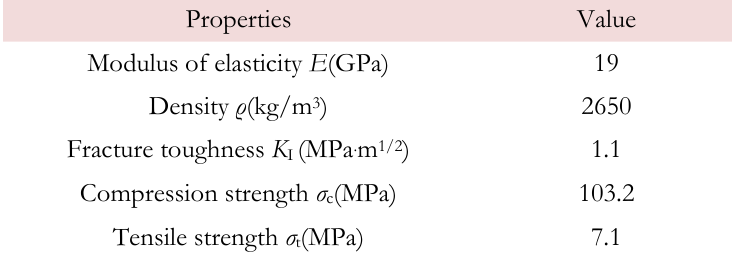
Table 1: Mechanical properties of marble.